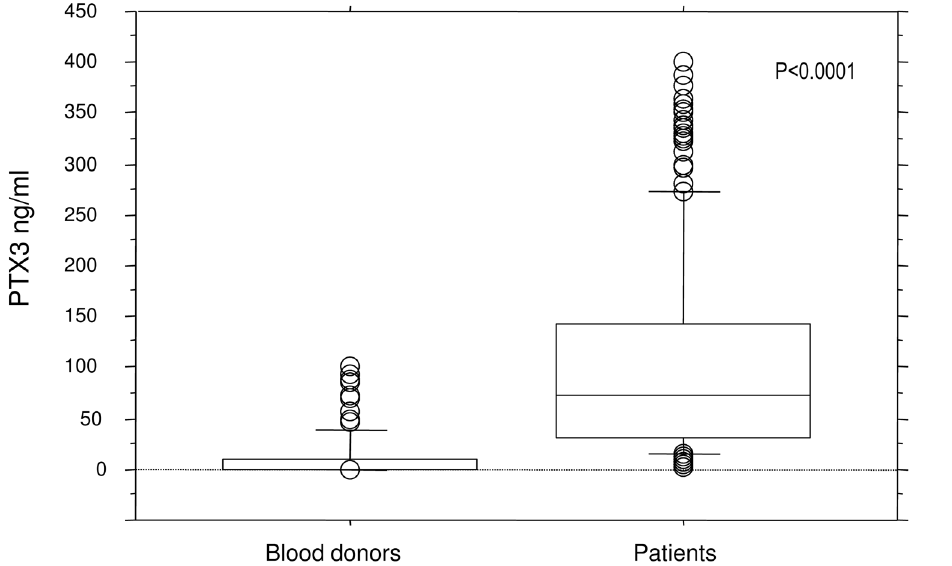
Figure 2. Serum levels of PTX3 in healthy controls (n=100) (left) and patients with SIRS or sepsis (n=261) (right) are shown. The PTX3 levels were elevated in the patients compared with the controls (Mann-Whitney, p , 0.0001). The ranges (0–100 ng/ml in controls, 0.8–400 ng/ ml in patients), the interquartile ranges (in controls 0.0–9.7 ng/ml and 31.1–143.3 ng/ml in patients) and the medians (0 ng/ml in controls and 71.3 ng/ml in patients) are indicated.